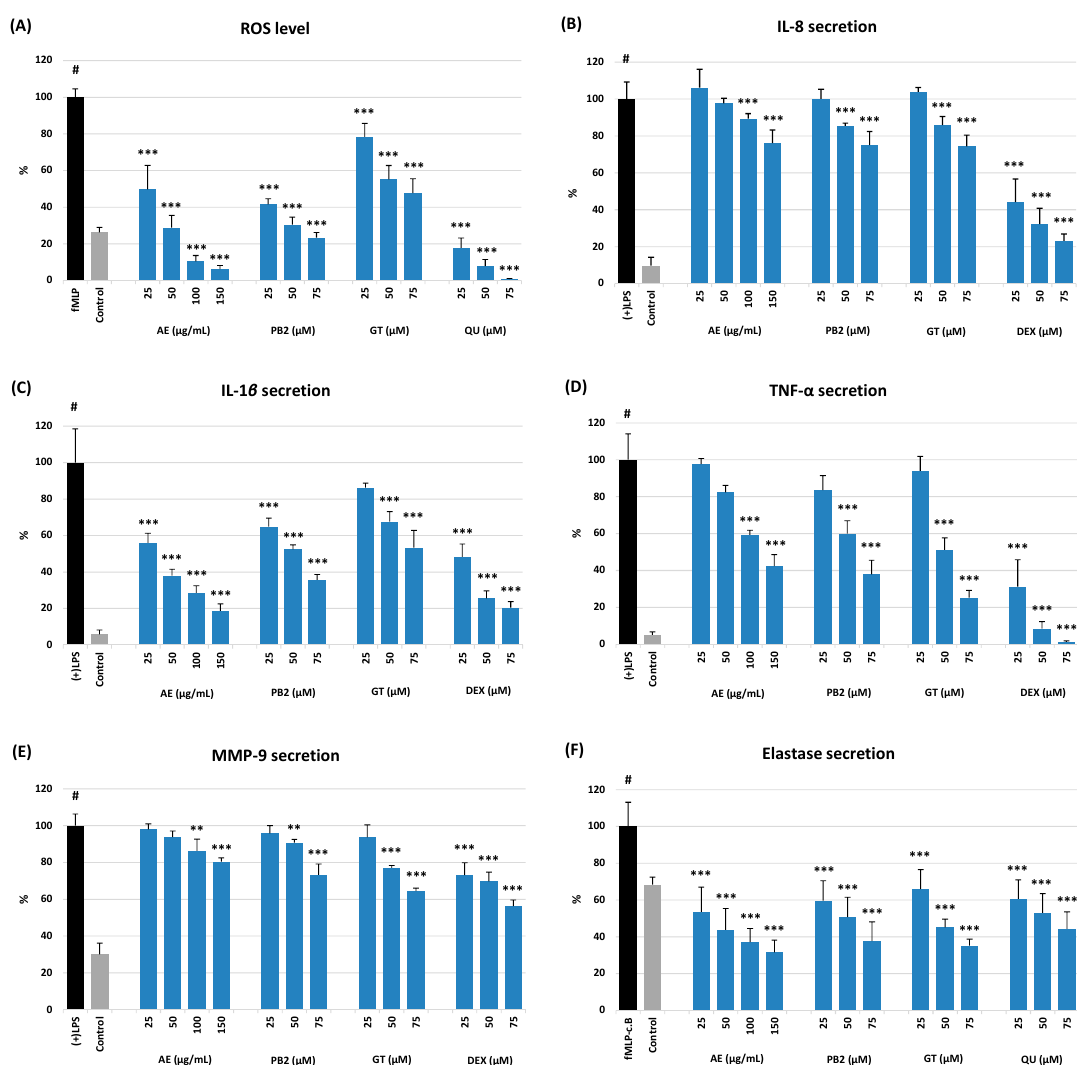
Figure 5. Effect of AE at 25, 50, 100, 150 µ g/mL (6, 12, 24, 36 µ g GAE/mL), model polyphenols (PB2 and GT), and positive controls (QU and DEX) on: ( A ) ROS level; and secretion of ( B ) IL-8; ( C ) IL-1 β ; ( D ) TNF- α ; ( E ) MMP-9; and ( F ) ELA-2 by stimulated human neutrophils. Data expressed as means ± SD of three independent experiments performed with cells isolated from five independent donors. Statistical significance: # p < 0.001 compared to the non-stimulated control; * p < 0.05, ** p < 0.01, *** p < 0.001 compared to the stimulated control (+)LPS.